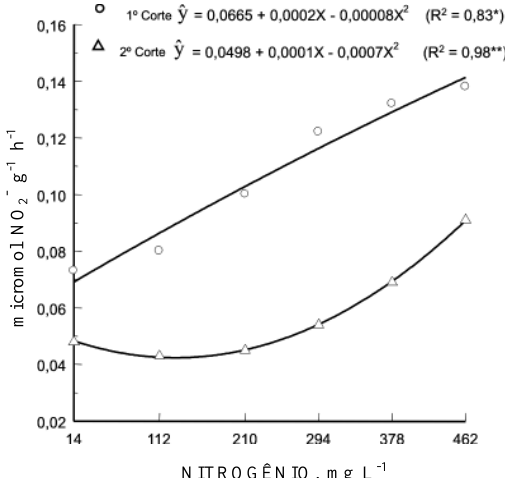
Figura 4. Atividade da redutase do nitrato em lâminas de folhas recém-expandidas (LR) do capim-Aruana, no primeiro e segundo corte, considerando as doses de N em solução